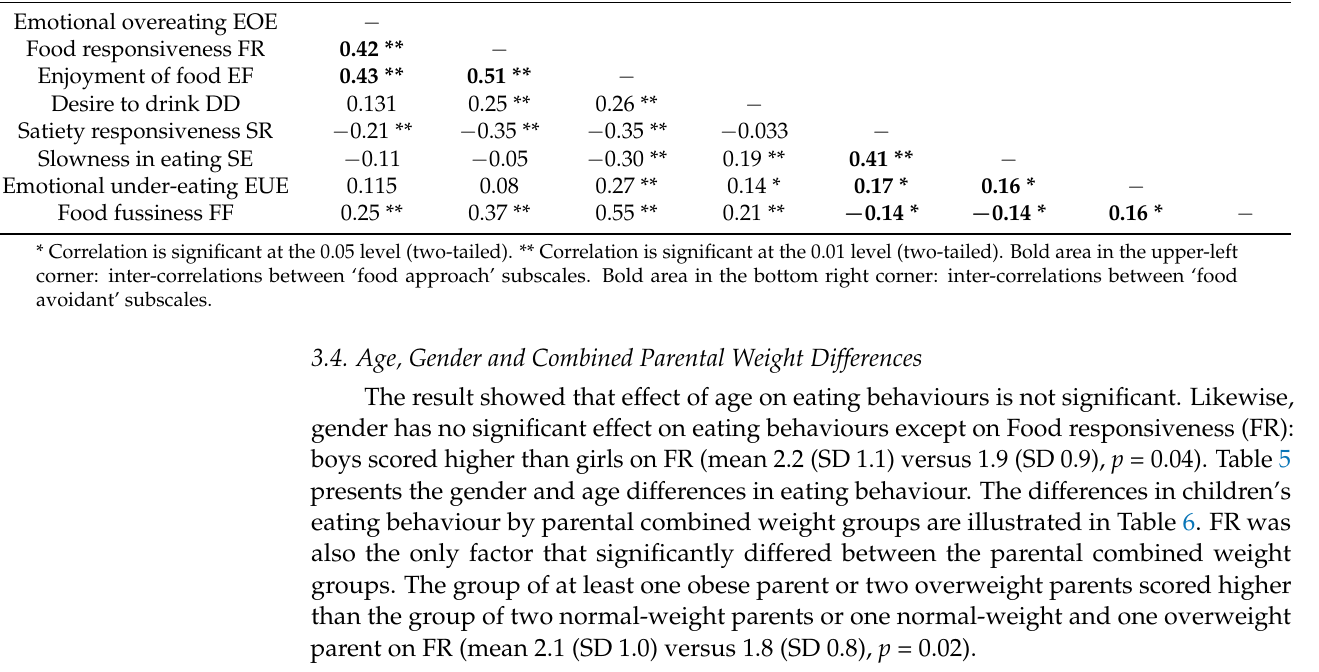
Table 4. Pearson’s correlations between the CEBQ subscales (N = 200). EOE FR EF DD SR SE EUE FF